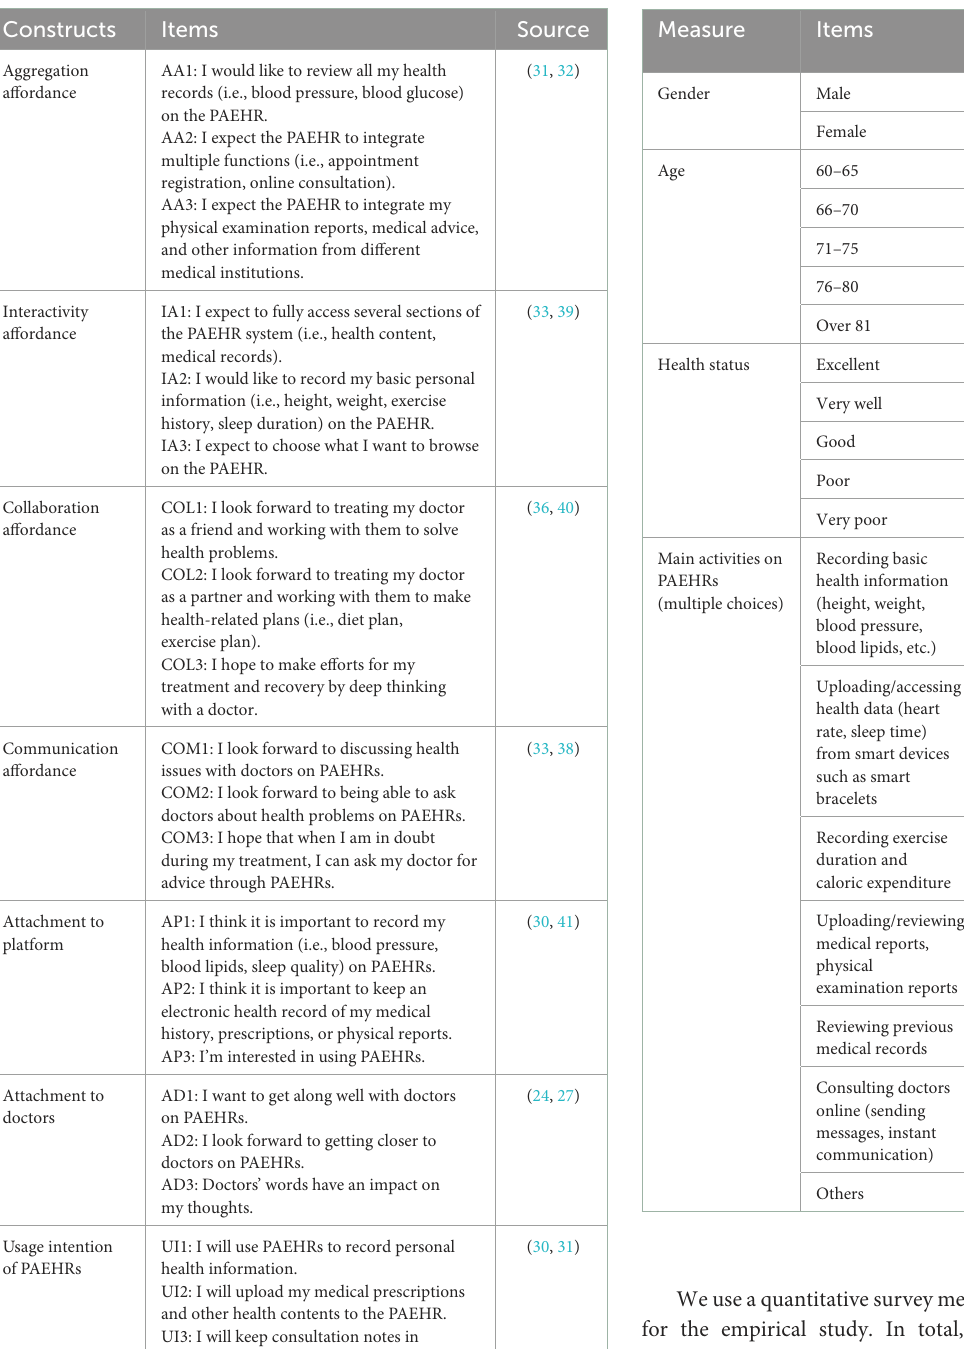
TABLE 1 Research items and references. TABLE 2 Demographic information of participants ( N =